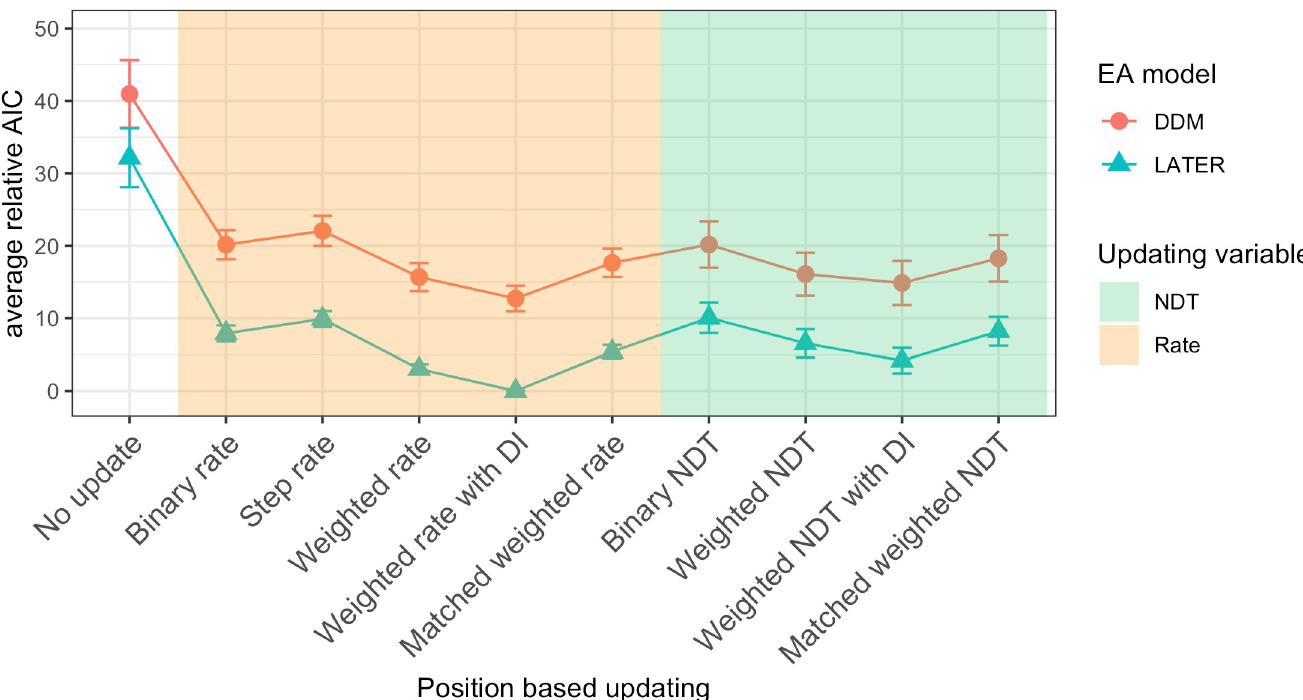
Fig 6. Model comparison for position-based updating. Mean relative AIC for all different position-based updating rules when using the best updating rules for response-critical feature (RCF) and color. The different background colors mark rules that update either the rate (orange) or the non-decision time (green). Error bars represent the standard error of the mean over participants and sessions. DI: distractor inhibition; NDT: Non-decision time.